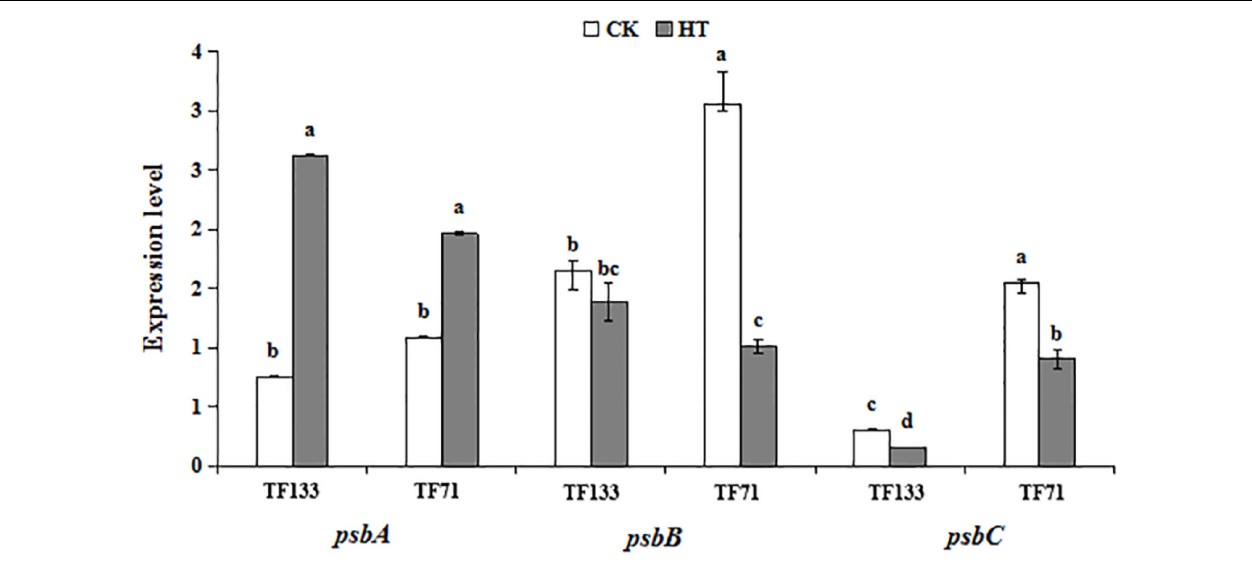
FIGURE 6 | The effects of heat treatments on gene expression of PsbA , PsbB , and Psbc in tall fescue leaves in heat-sensitive genotype “TF133” and heat-tolerant genotype “TF71” under normal conditions or heat stress.CK was the control (22/18 ◦ C for light/dark), while HT was the heat treatment (40/35 ◦ C for light/dark). All the plants were treated for 1 day. Mean ± SD were calculated from five biological repeats. Different letters indicated statistical difference significance at P < 0.05 among the different treatments groups by Duncan’s multiple range